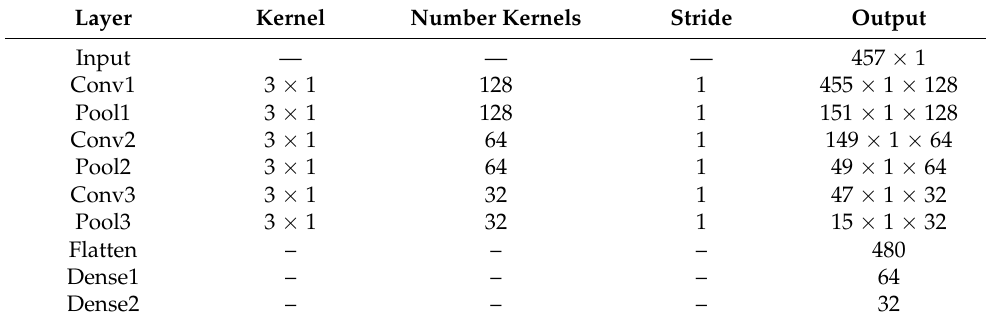
Table 2. The structure parameters of 1D-CNN.